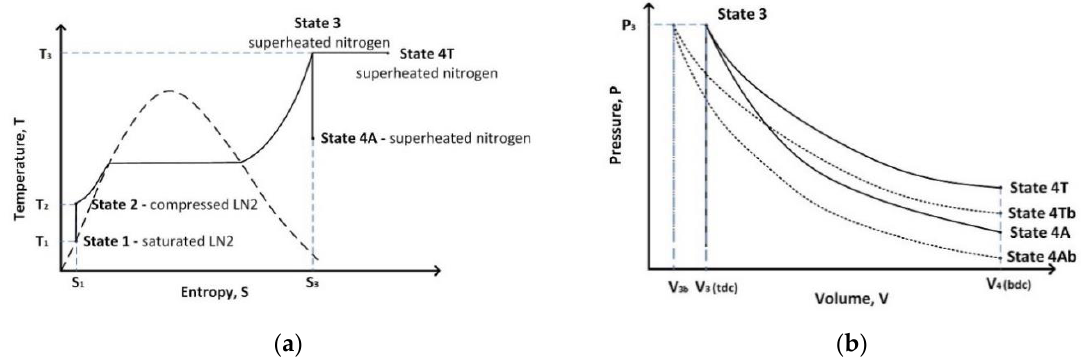
Figure 1. Thermodynamic processes of the liquid nitrogen (LN 2) engine cycle. ( a ) Temperature-entropy diagram of the cycle; ( b ) pressure-volume diagram of the N 2 expansion process. The dotted black curves represent the process where part of the clearance volume of the engine is occupied by the heat exchange fluid so the effective compression ratio is increased.